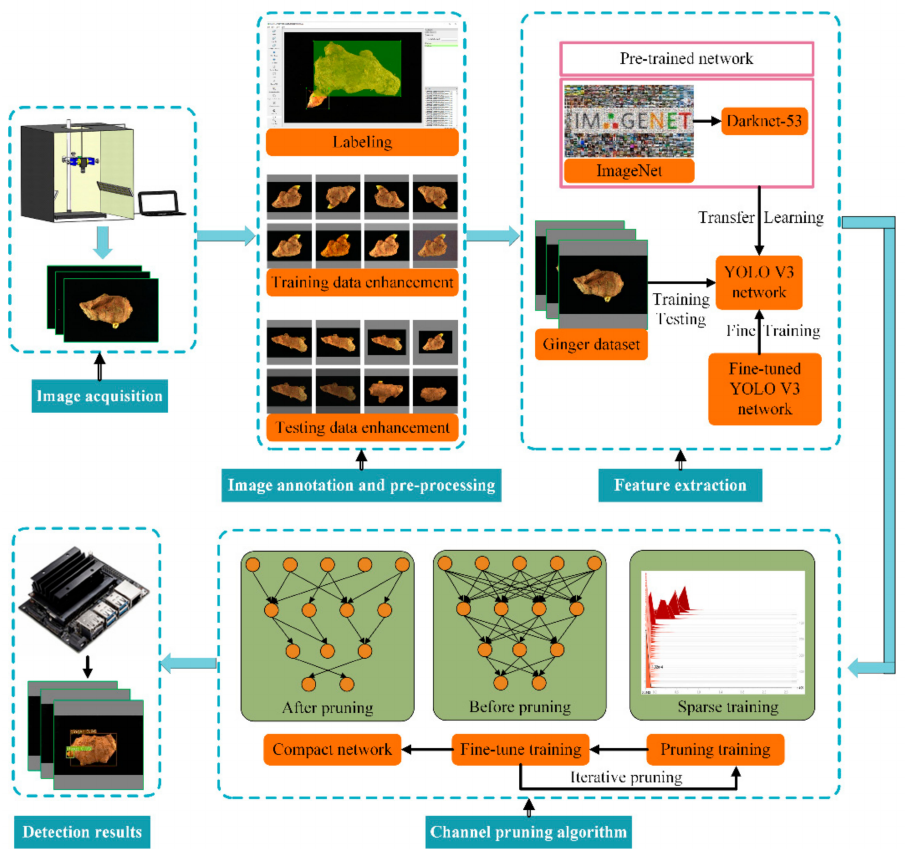
Figure 3. Overall process of proposed